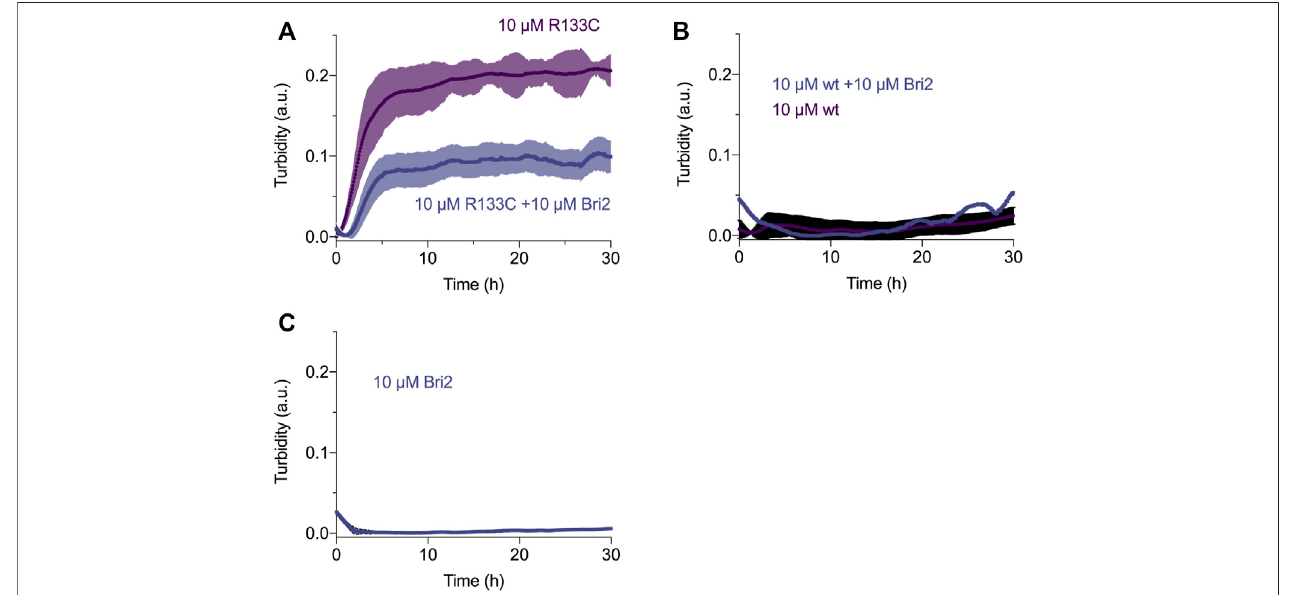
FIGURE 5 | Aggregation kinetics of wildtype and R133C mutant N3 EGF 1 – 5 proteins. (A) Aggregation kinetics of R133C mutant N3 EGF 1 – 5 in the presence/ absence of Bri2 BRICHOS at 1:1 ratio. (B) Aggregation kinetics of wildtype N3 EGF 1 – 5 in the presence/absence of Bri2 BRICHOS at 1:1 ratio. (C) Monitoring of the aggregate of Bri2 BRICHOS alone. The shadow in each condition represents the standard error of the mean (SEM) of three independent experiments performed in triplicate ( n =